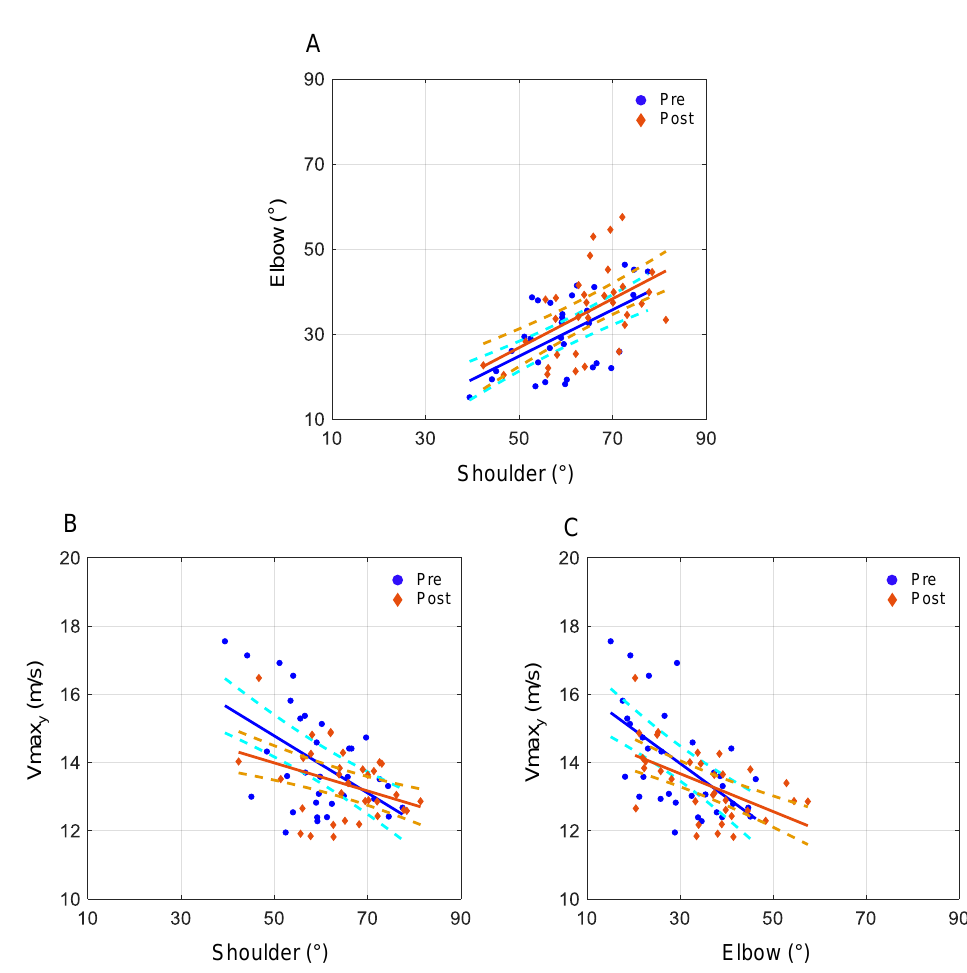
Figure 6. Regression analysis between the shoulder and elbow angles ( A ). Regression analysis of the maximum velocity (along the y -axis direction) and shoulder ( B ) and elbow ( C ) angles. All the estimations were performed both before ( Pre ) and after ( Post ) the training program. Table 2. Spearman correlation coefficient R among joint kinematic angles and velocity.